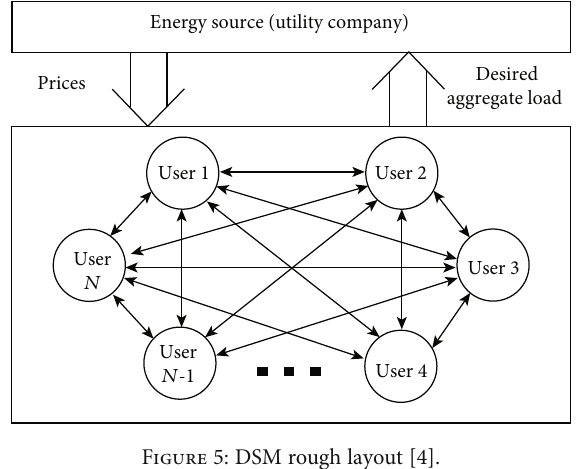
Figure 5: DSM rough layout [4].